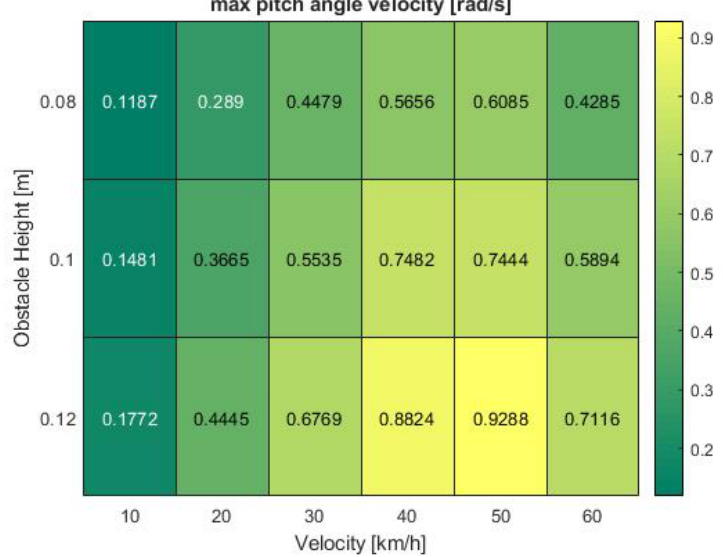
Figure 9. Pitch angle velocity at various bump obstacle heights and vehicle velocities in the